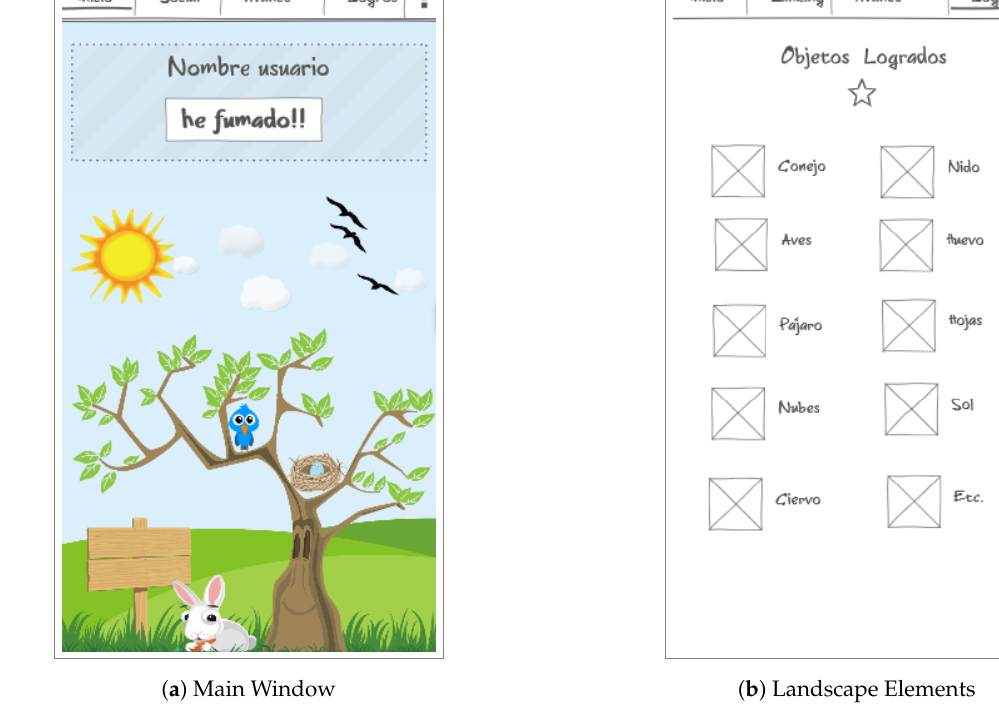
Figure 1. First version Mockups of